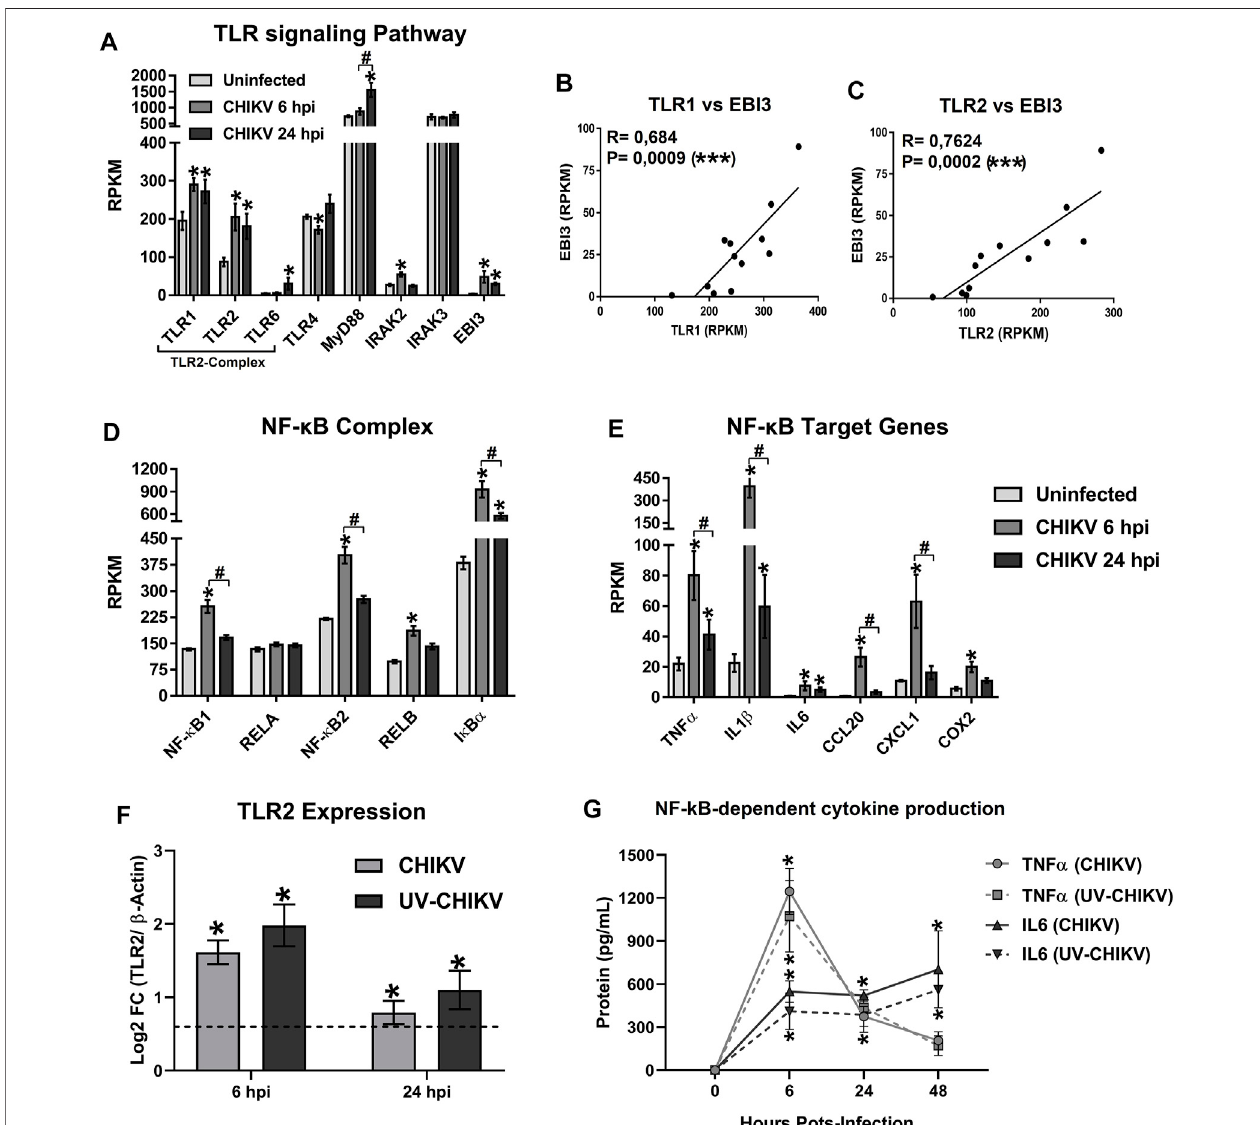
FIGURE 4 | The CHIKV infection of MDMs induces the mRNA expression of TLR1/2 signaling pathway components, NF- κ B-complex and EBI3. Human MDMs cultures were left uninfected or infected with CHIKV at MOI 5. Cell lysates were obtained at 6 and 24 hpi, and RNA-seq was performed. mRNAs abundance (RPKM) of TLR signaling pathway components and EBI3 (A) in uninfected and CHIKV-infected MDMs. Data are presented as the mean ± SEM. Kruskal – Wallis test with Dunn ’ s post-test was performed. Signi fi cant results between uninfected and CHIKV-infected MDMs are de fi ned as p < 0.05 (*), p < 0.01 (**) and p < 0.002 (***). Signi fi cant results between treatment-times comparisons are de fi ned as p < 0.05 (#), p < 0.01 (##) and p < 0.002 (###) n = 4. Pearson ’ s correlation between TLR1 (B) or TLR2 (C) , with EBI3 mRNA abundance (RPKM) in uninfected and CHIKV-infected MDMs. Signi fi cant results are de fi ned as p < 0.05 (*), p < 0.01 (**) and p < 0.002 (***). mRNA abundance(RPKM)ofNF- κ B-complexcomponents (D) ,andNF- κ B-targetgenes (E) ,inuninfectedandCHIKV-infectedMDMs.Dataarepresentedasthemean±SEM. Kruskal – Wallis test with Dunn ’ s post-test was performed as decrived in (A) . Human MDMs cultures were infected at MOI 5 of CHIKV or a non-replicative UV-inactivated CHIKV (UV-CHIKV). TLR2 mRNA expression (Log2 FC) (F) and NF- κ B-dependent cytokine production (TNF α and IL6) (G) were evaluated at 0, 6 and 24 hpi, by RT- qPCRandELISA,respectively.Dataarepresentedasthemean±SEM.Kruskal – WallistestwithDunn ’ spost-testwasperformed.Signi fi cantresultsbetweenuninfected andCHIKV-orUV-CHIKV-infectedMDMsarede fi nedas p < 0.05(*), p < 0.01(**)and p < 0.002(***).Signi fi cantresultsbetweenCHIKV-infectedMDMsandUV-CHIKV- infected MDMs are de fi ned as p < 0.05 (#), p < 0.01 (##) and p < 0.002 (###). n = 4.